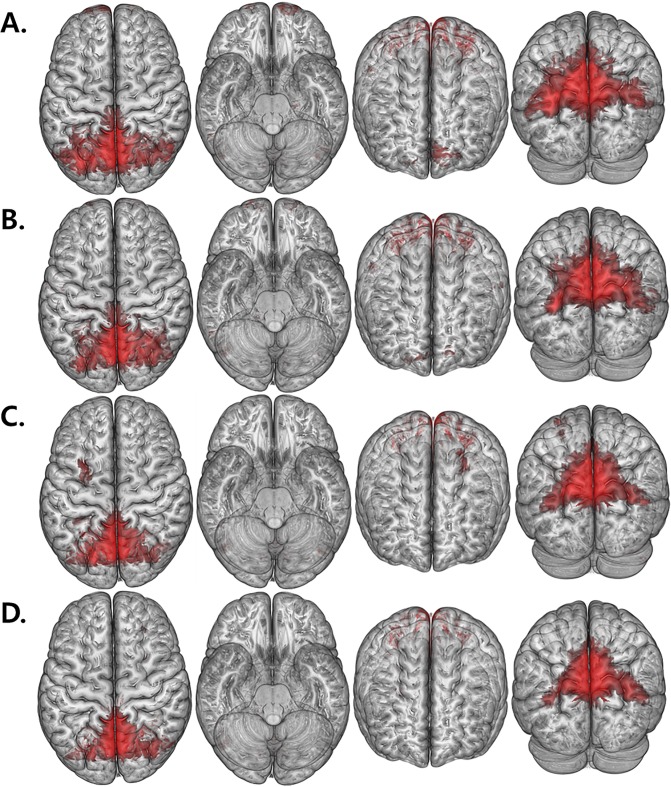
Renderd t maps of FC value.(A, B) show the FC maps of HAND with the seed located in the left and right precuneus, respectively. (C, D) show the FC maps of nonHAND group with the seed located in the left and right precuneus (P < .005, uncorrected).